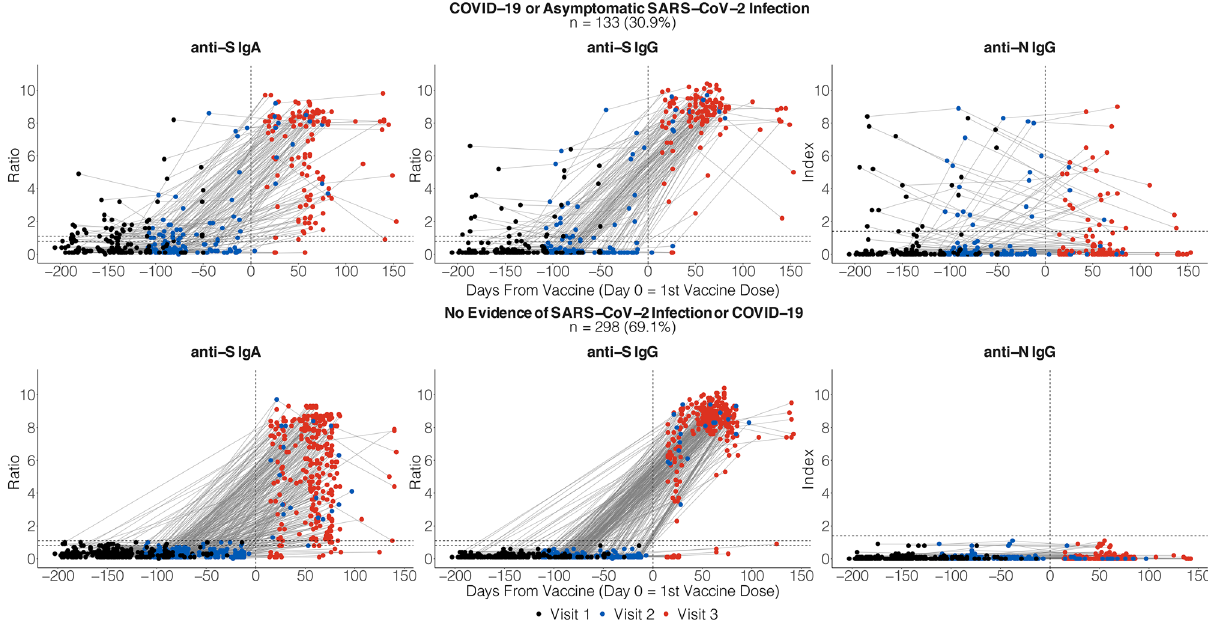
Figure 1. Change in anti-spike IgA ratio, anti-spike IgG ratio and anti-N IgG index relative to time of COVID vaccination comparing those with evidence of prior SARS-CoV-2 infection to those with no evidence of prior infection. Data visualization was performed in R with the ggplot2